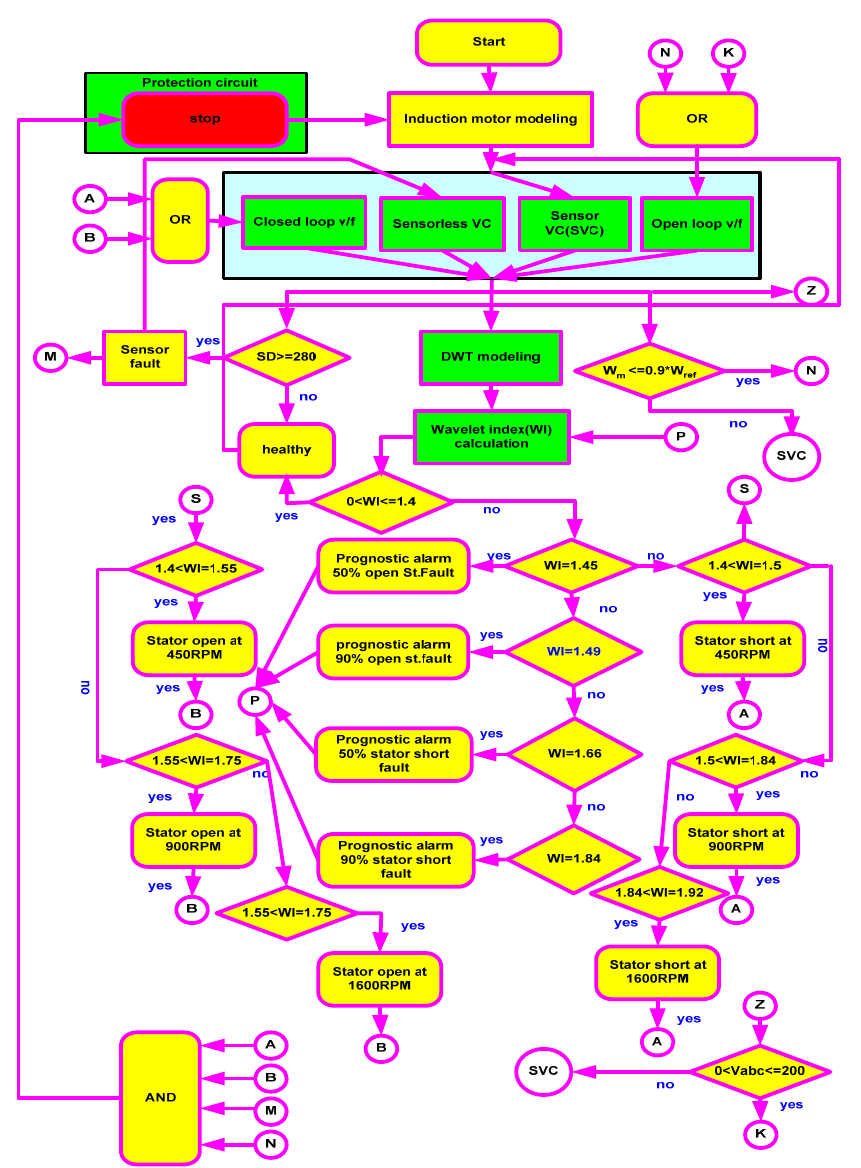
Figure 27. Expanded flow chart of the